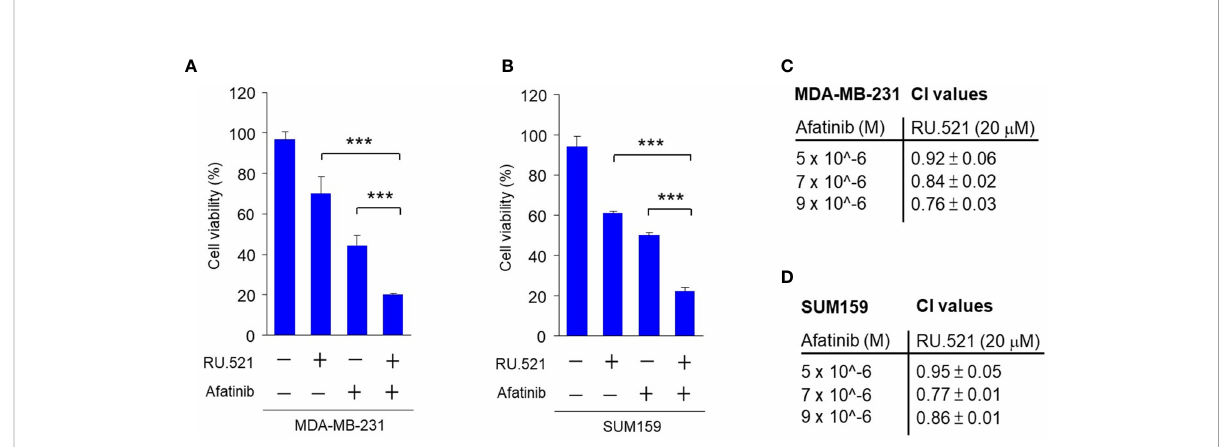
FIGURE 6 The synergistic effect in inhibiting the viability of TNBC cells by combining RU.521 and afatinib in serum-replete media. A and B, MDA-MB-231 (A) and SUM159 (B) cells were treated with RU.521 (20 m M) or afatinib (5 m M) alone, and combined treatment with RU.521 plus afatinib in normal growth media for 48 hr. Cell viability was determined by crystal violet staining and detected by absorbance at OD595 nm. The data from three independent biological repeats data are plotted and presented as means ± SD. Statistical signi fi cance was calculated by Student ’ s t-test. ***, p < 0.001. C and D, MDA-MB-231 (C) and SUM159 (D) cells were treated with and without RU.521 (20 m M) in the presence of different concentrations of afatinib (0, 5, 7, 9 m M) for 48 hr. Cell viability was determined as described in (A) and (B) The data were analyzed by the formula of CI=(D) 1 /(Dx) 1 +(D) 2 /(Dx) 2, in which a CI < 1 suggests